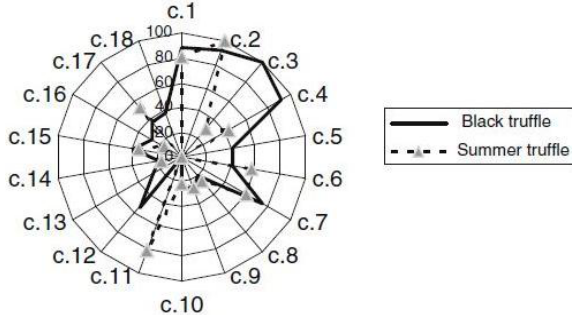
Figure 4. Spider web diagram comparing the GC-O olfactometric profiles (normalized so that the odorant showing maximum MF (%) = 100) obtained from black and summer truffles (reprinted from [122] with permission from